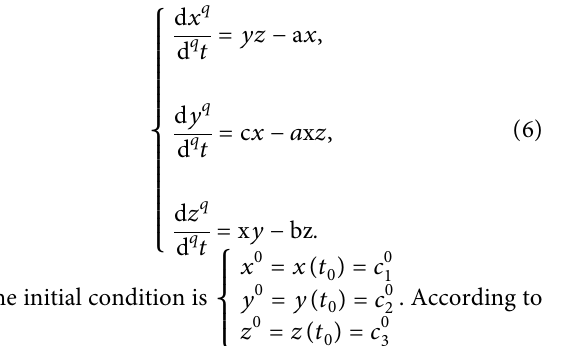
∈ [− 15 , 15 ] and y ∈ [− 20 , 20 ] 0 0